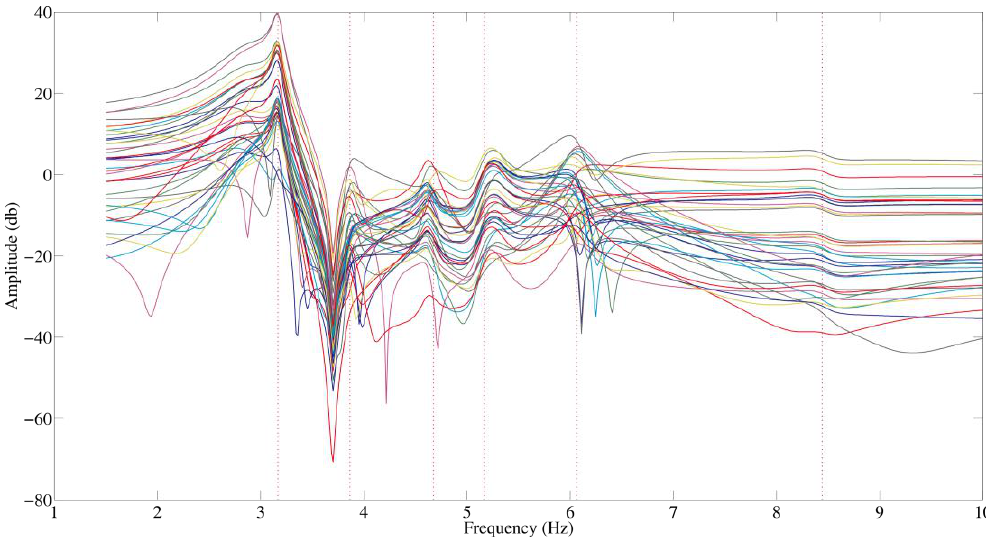
Fig. 4. Exact elements of the pseudo transfer matrix